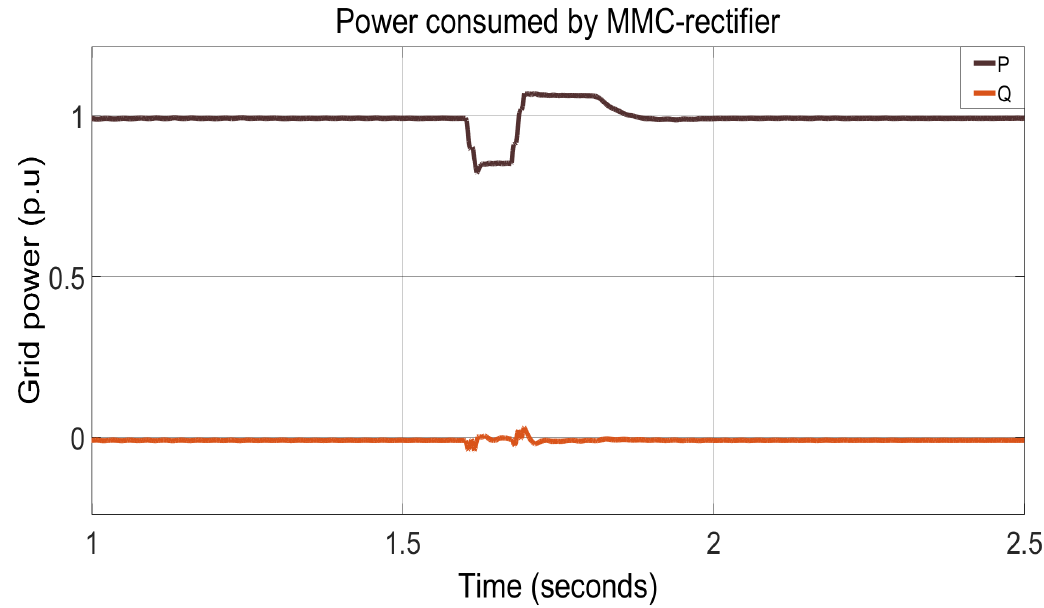
Figure 23. Power drawn from grid to feed